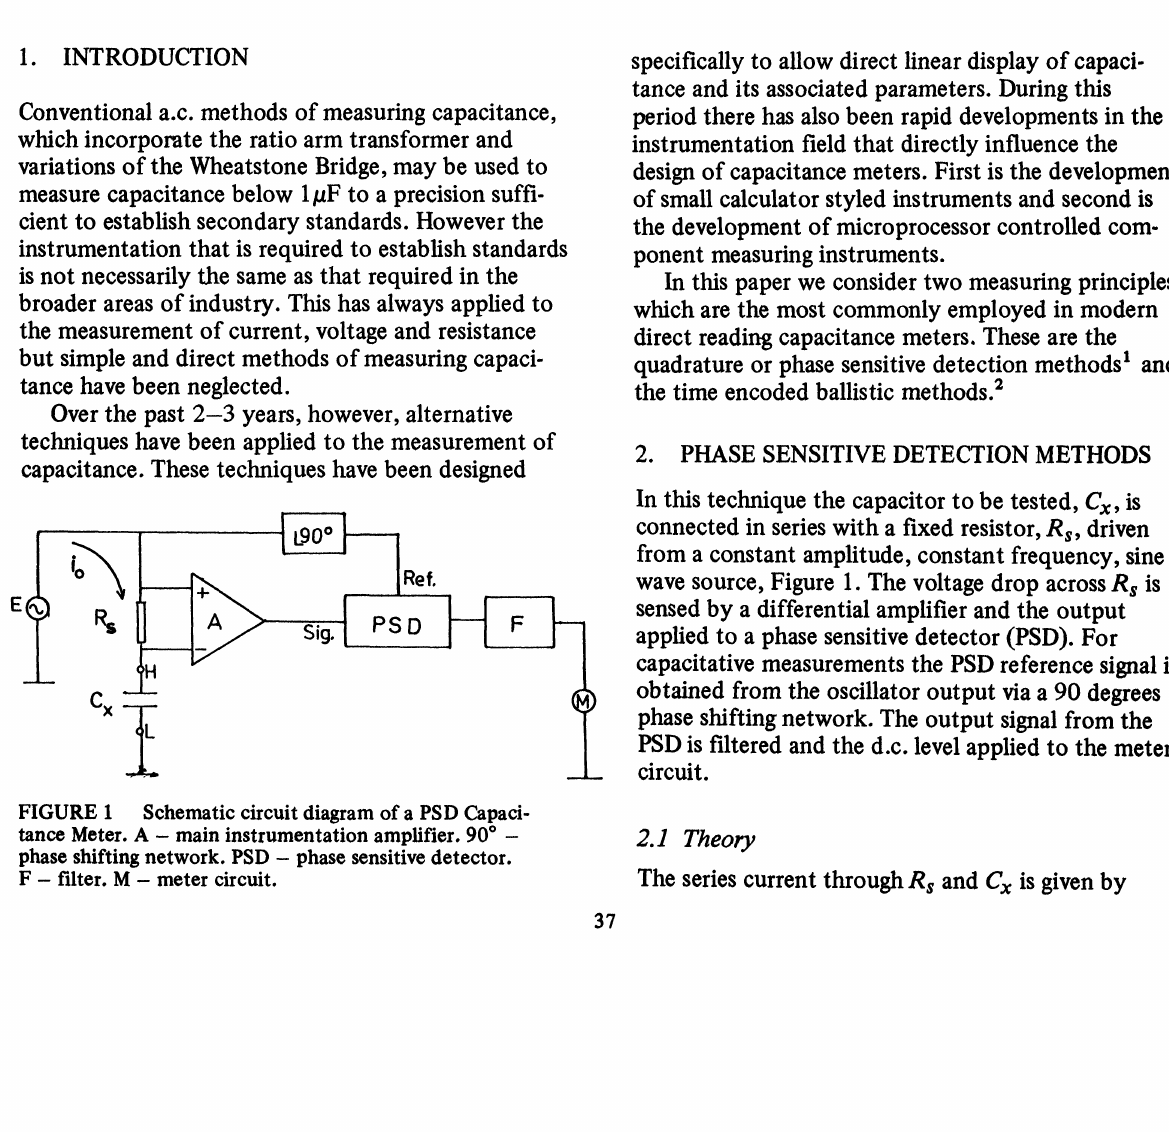
Schematic circuit diagram of a PSD Capaci- tance Meter. A main instrumentation amplifier. 90 phase shifting network. PSD phase sensitive detector. F- filter. M- meter